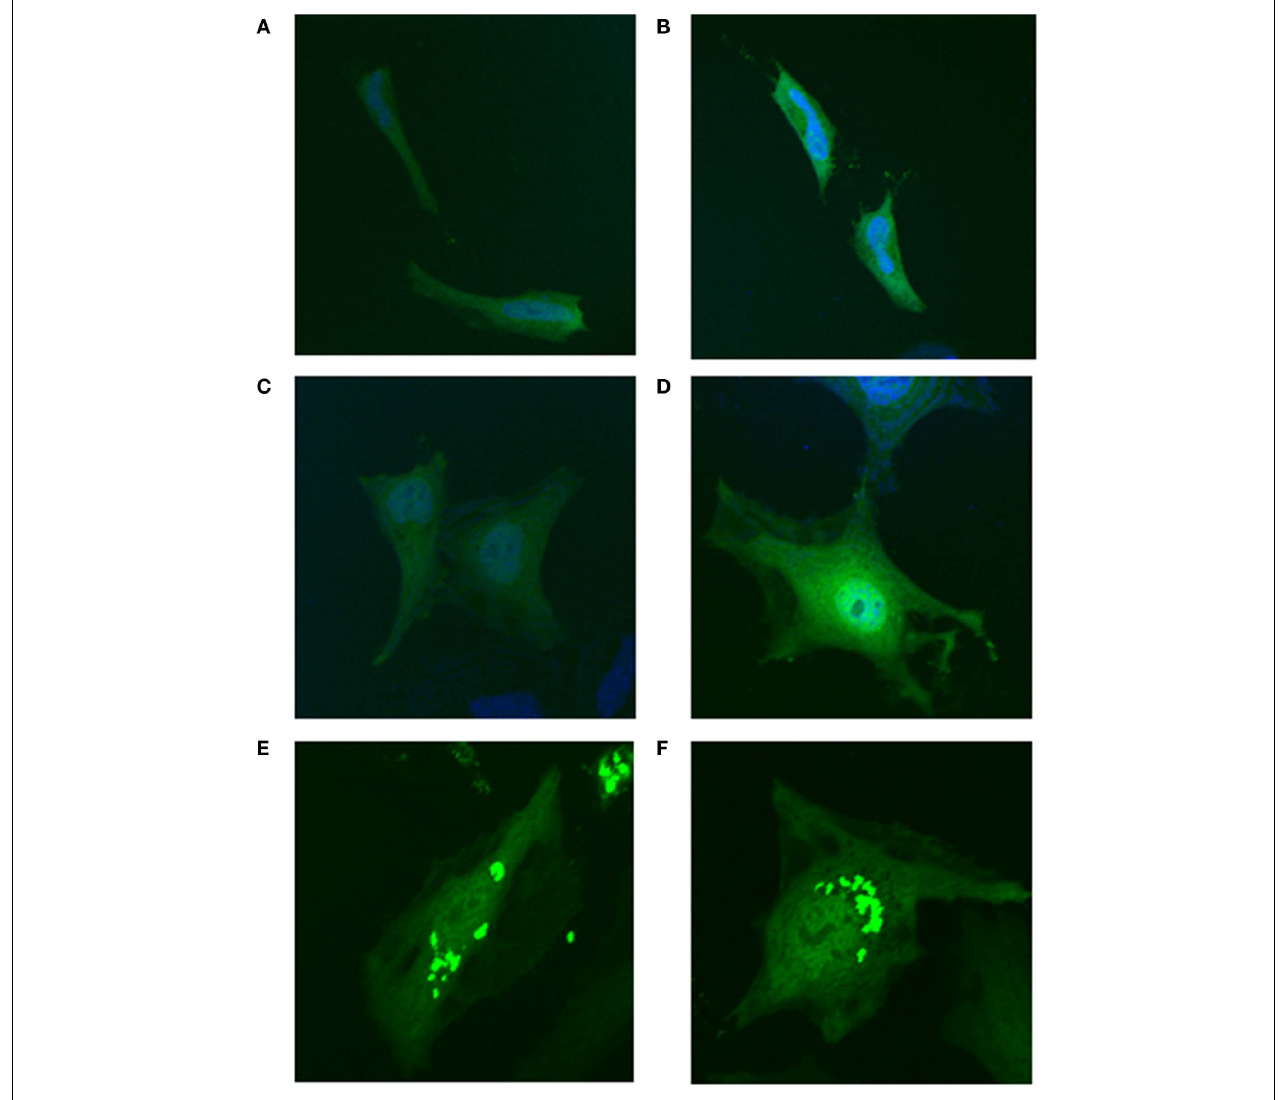
FIGURE 11 | Sumoylation of MTHFS at K140 and/or K190 is required for clustering under purine-deficient conditions. MTHFS-K140R, K190R-GFP fusion proteins were expressed in HeLa cells and visualized by confocal microscopy as described in Section “Materials and methods.” (A, B) The